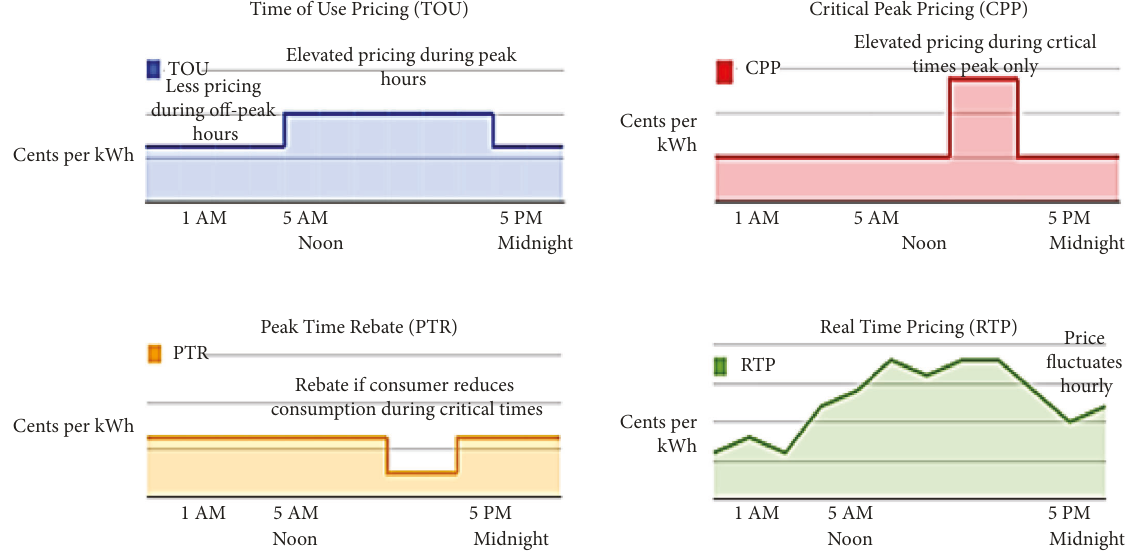
Figure 1: Types of TVR; source: advanced energy perspective-advanced energy economy